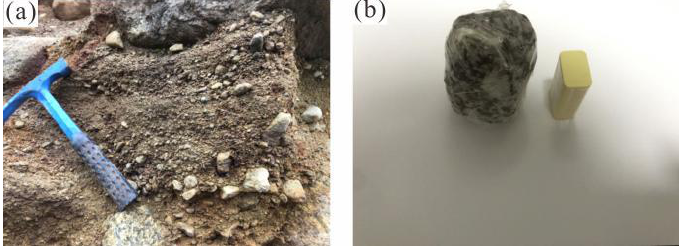
Figure 3. Intact glacial till sample. ( a ) Field sampling point of glacial till. ( b ) Cylindrical gacial till sample.